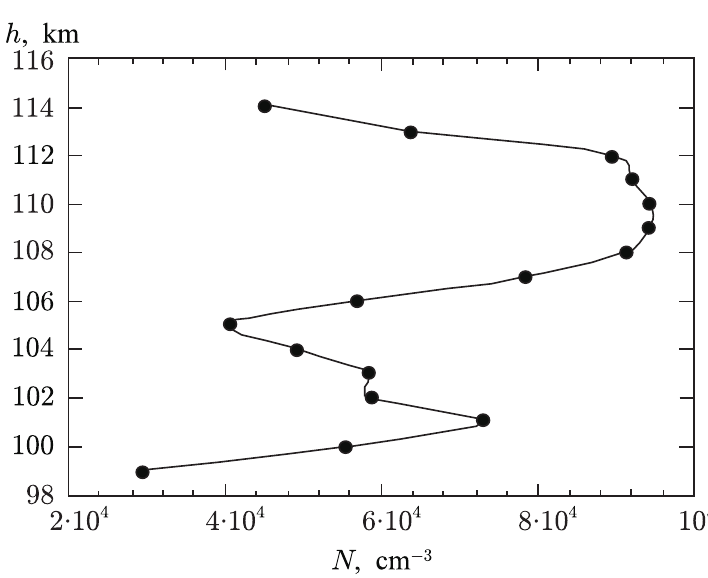
Fig. 3. The altitude pro(cid:12)le of the electron concentration N ( h ) obtained for the time 16:29 by two-frequency API measurements on 2006-10-04. The local maximum of the N ( h )-pro(cid:12)le at an altitude of 101 km corresponds to the sporadic E-layer and N ( h ) maximum at an altitude of 110 km shows the maximum electron density of